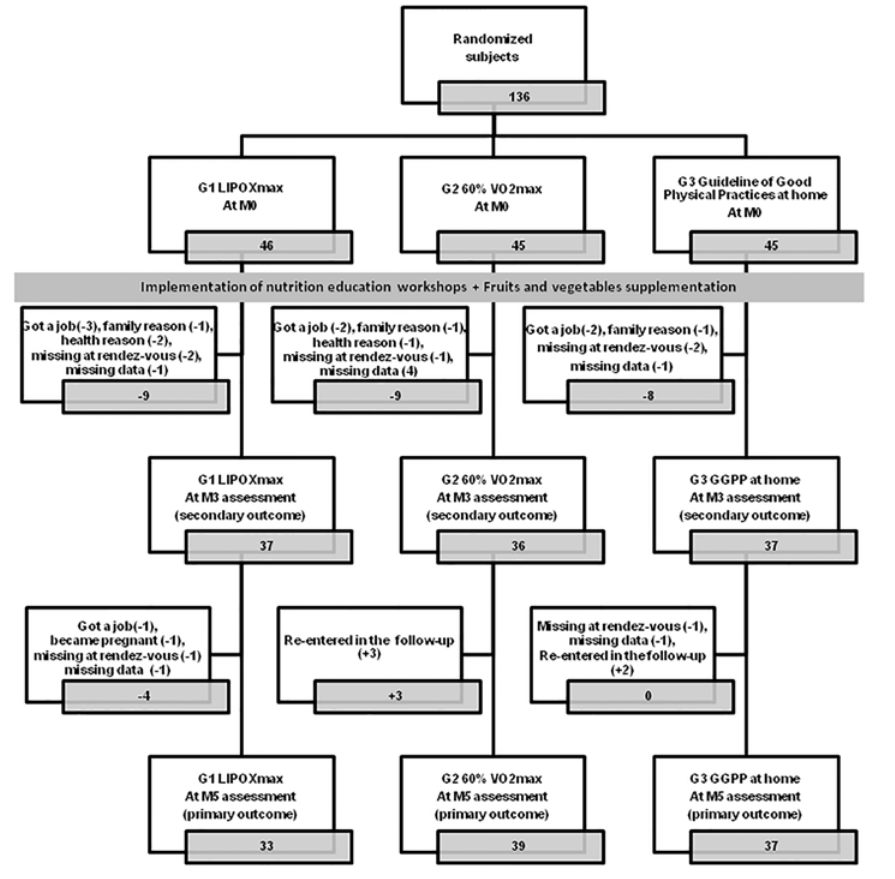
Fig 1. LIPOXmax Réunion Flow